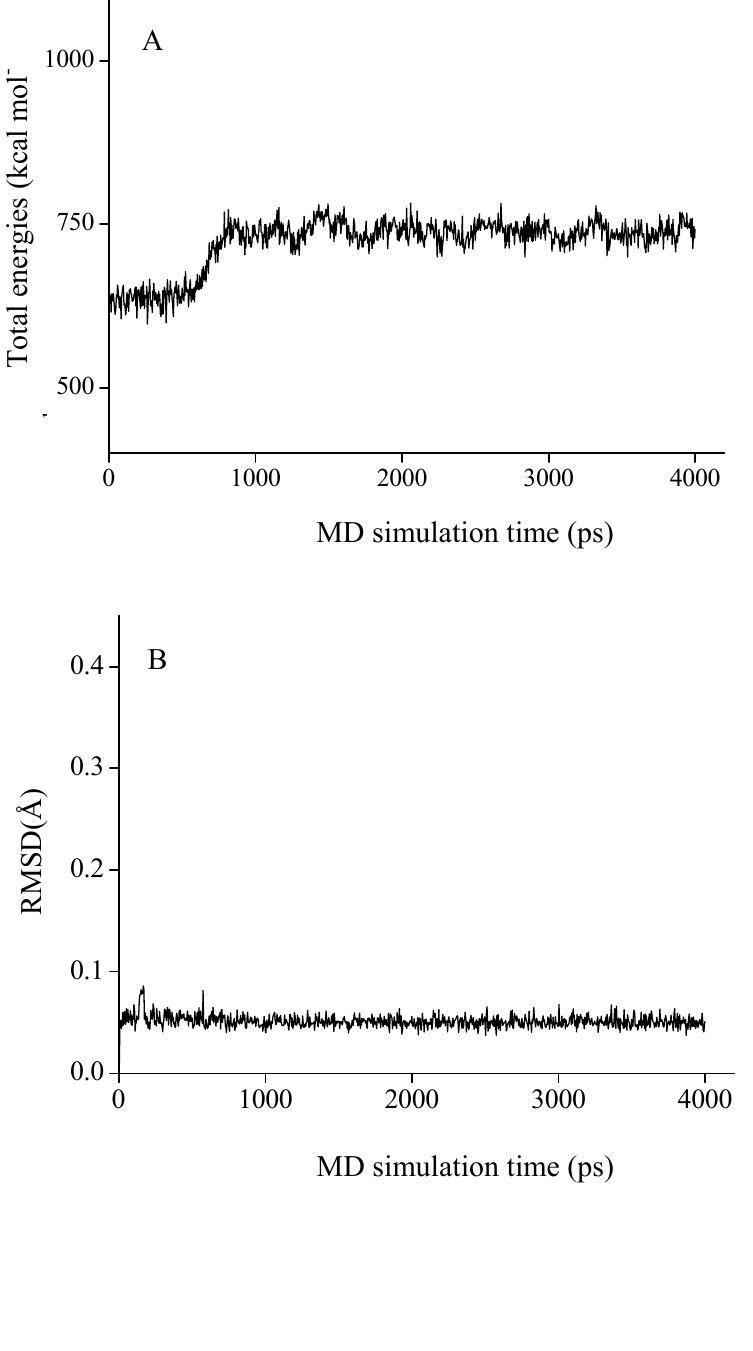
Figure 3. The time-evolution total energies ( A ) and backbone-atom root mean square deviations (RMSD, B ) for the chamaejasmine-TB complex during the MD